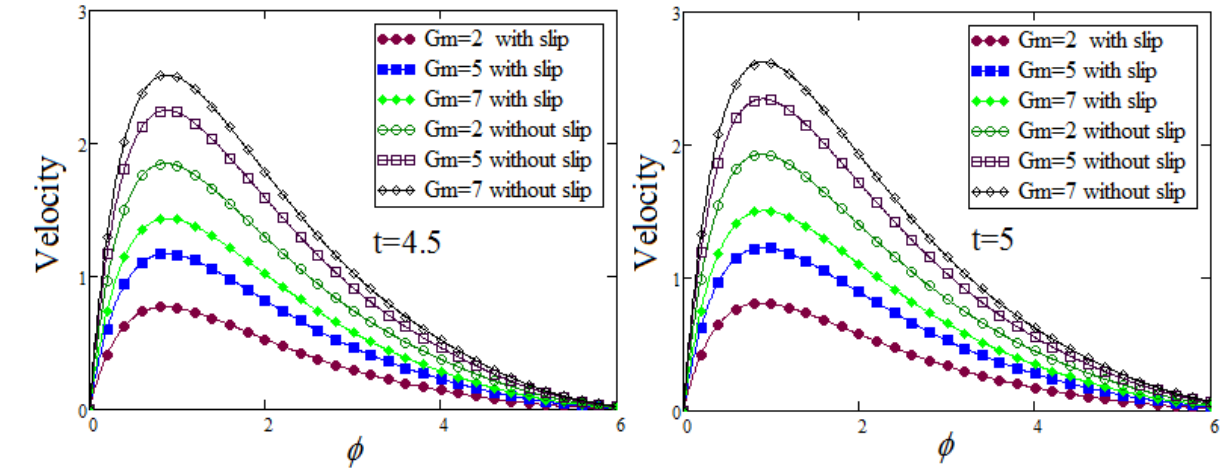
Figure 15. Graphical representations of velocity profile in the presence of slip and no slip conditions by taking the dissimilar values of Gm at two different levels of time, when Gr = 5, Pr = 11, ℘ = 0.4, ω = 0.5, Sc = 9, α = 0.5 β = 0.3, and γ = 0.4.